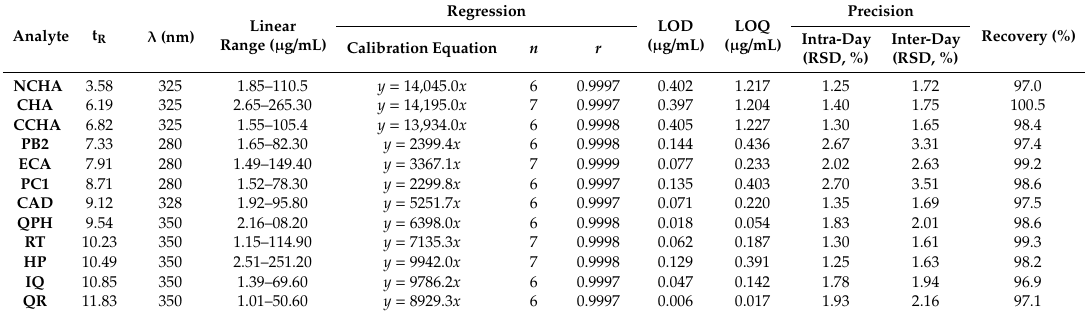
Table 1. Linearity, sensitivity, precision and accuracy data for the proposed HPLC-PDA method. Analyte t R λ